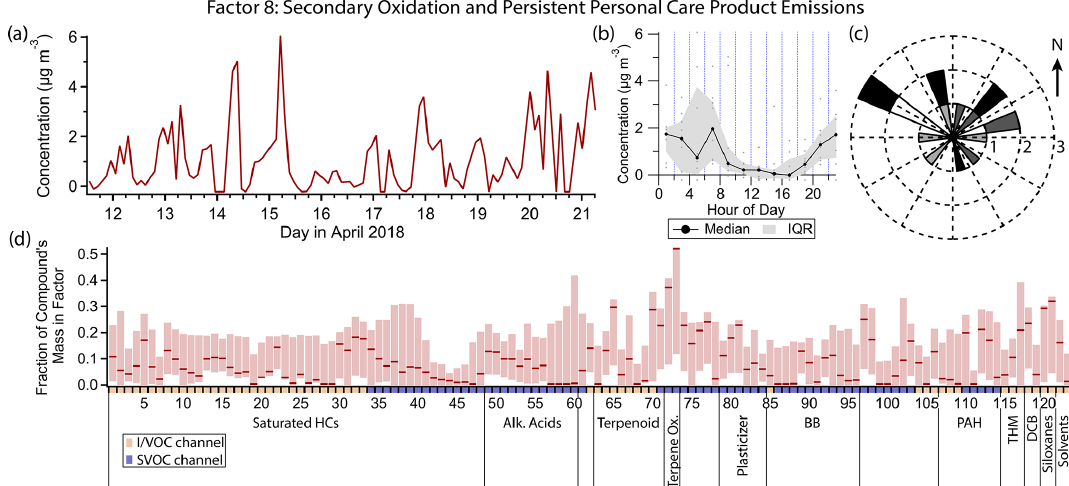
Figure 13. (a) Factor 8 timeline. (b) Diurnal profile for Factor 8. (c) Rose plot showing correlation of elevated emissions and wind direction. (d) Factor 8 composition profile. See Fig. 4 description for further information on how to read this